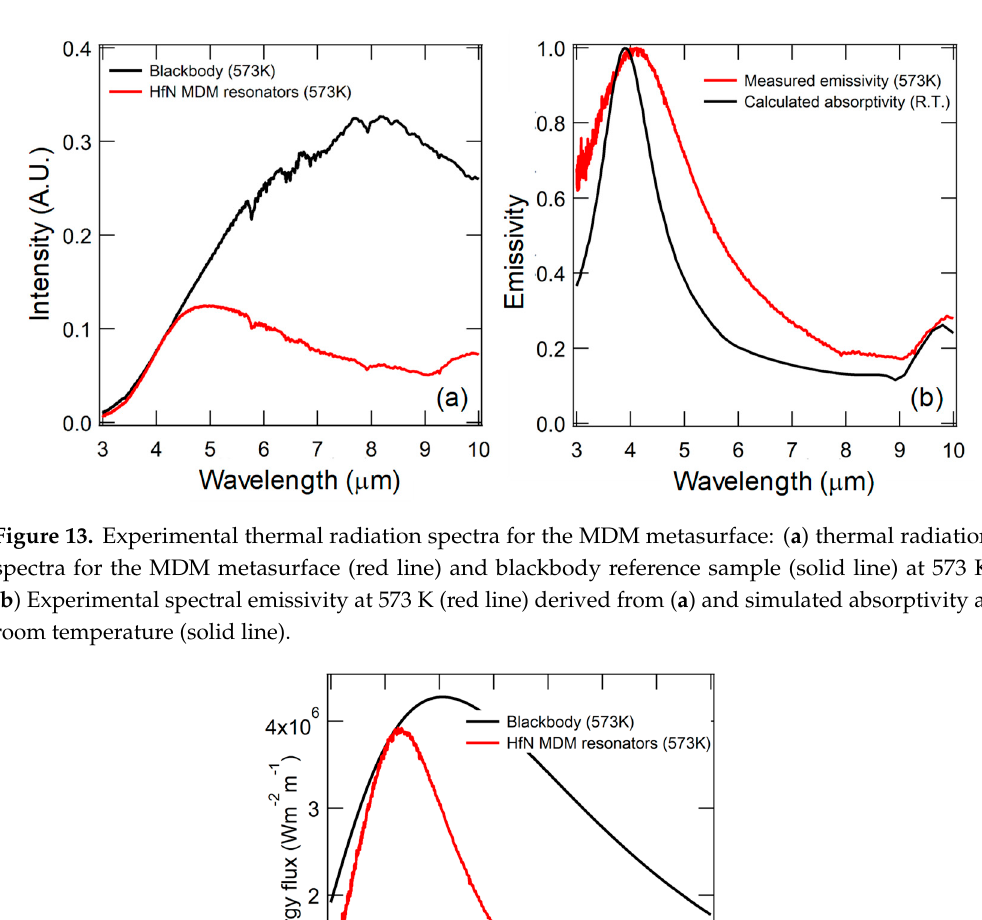
Figure 13. Experimental thermal radiation spectra for the MDM metasurface: ( a ) thermal radiation spectra for the MDM metasurface (red line) and blackbody reference sample (solid line) at 573 K. ( b ) Experimental spectral emissivity at 573 K (red line) derived from (a) and simulated absorptivity at room temperature (solid line).